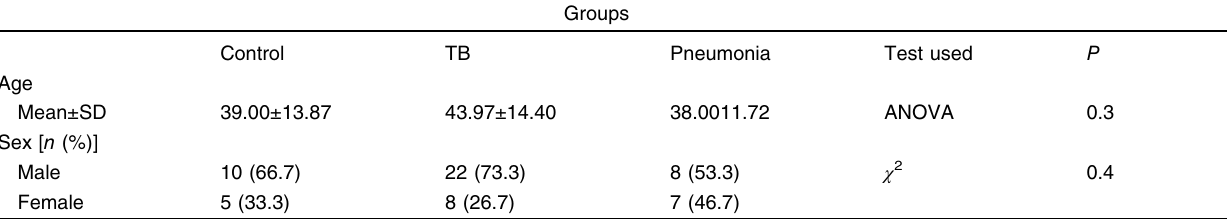
Table 1 Comparison among the three studied groups as regards age and sex